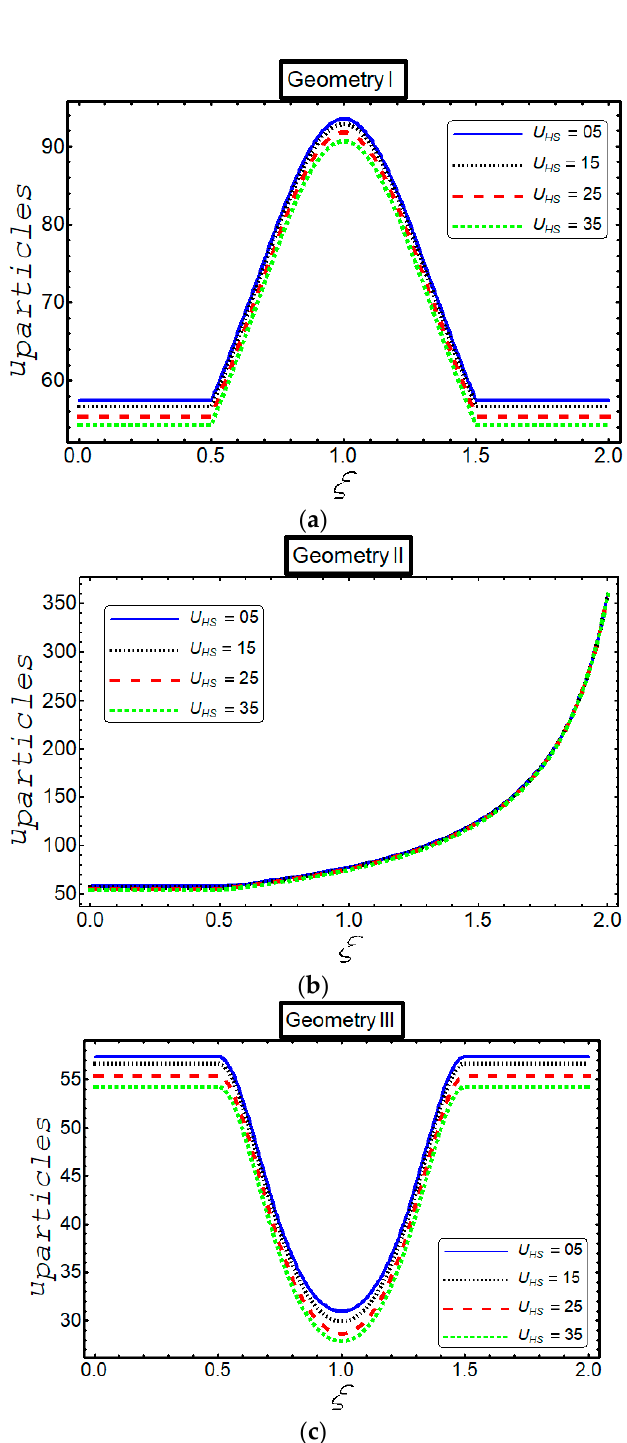
Figure 9. Velocity variation for Helmholtz–Smoluchowski velocity.